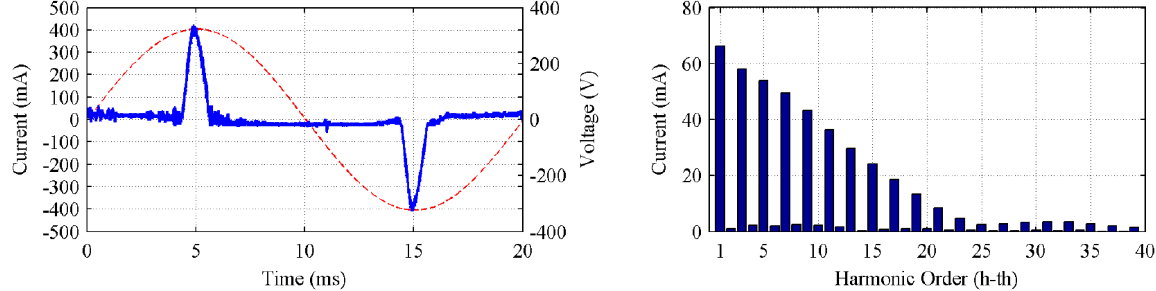
Figure 3. LED panel of 21 W with dimmer set to step 4: Current waveform and its harmonic spectrum.